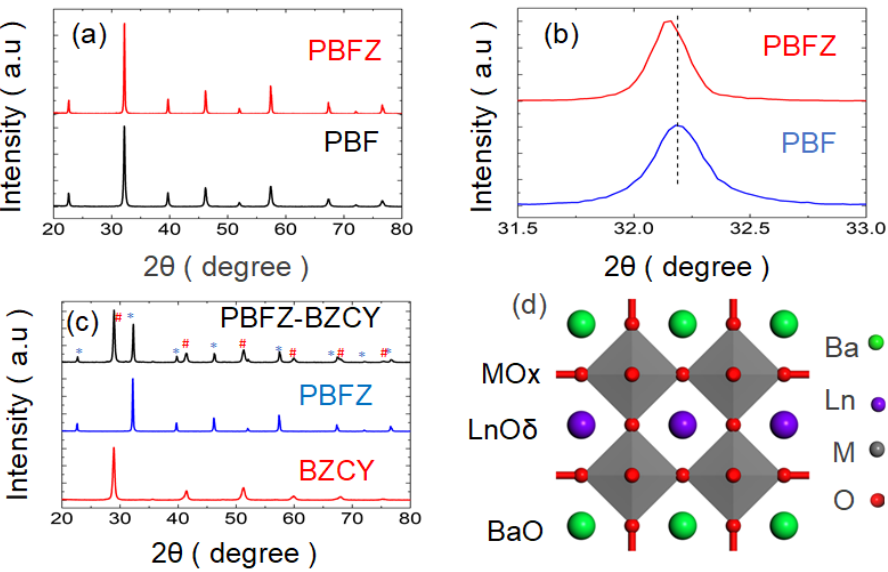
Figure 1. Crystal structure of PrBaFe 1.9 Zn 0.1 O 5+ δ and its chemical compatibility with BZCY: ( a ) XRD patterns of PBFZ and PBF; ( b ) enlarged XRD pattern at a specific degree; ( c ) XRD patterns of PBFZ- BZCY mixed powders; ( d ) layered perovskite crystal structure.